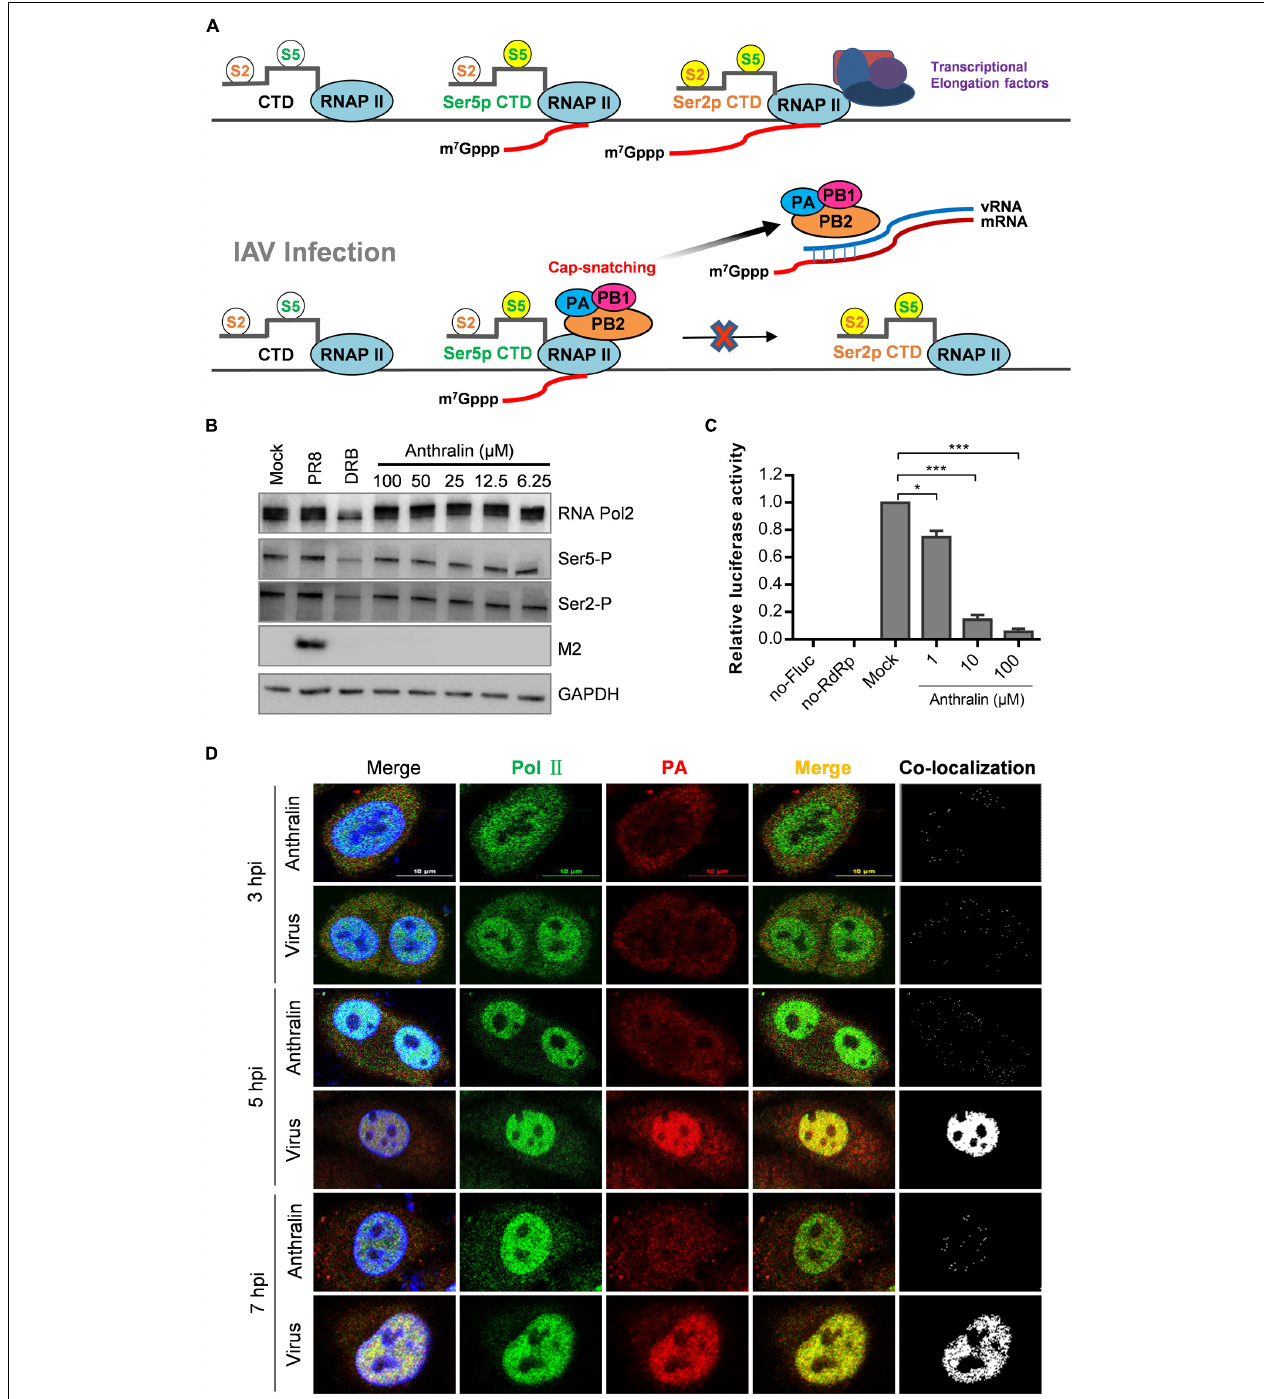
FIGURE 4 | Anthralin does not inhibit the host RNA polymerase activity. (A) The model illustrates the phosphorylation of Ser5 and Ser2 of RNAPII (phosphorylated residues are highlighted in bright yellow) and the synthesis of the initial cap structure of transcription. When the cell is infected with the IAV, the viral RdRp complexes complete RNA replication cycle by snatching the caps produced by host RNA II. (B) The expression of total RNAPII, serine 2 phosphorylated and serine 5 phosphorylated RNAPII, and the M2 protein of IAV were detected by Western blot. DRB used as a positive inhibitor of transcription initiation (lanes 3). (C) Various concentrations of anthralin were incubated with HEK293T cells stably transfected with pGL6-luc (Fluc), pcDNA3.1 expression vector for influenza virus PA, PB1, and PB2 proteins, and pRL-SV40-N (Rluc) as a transfection control, and DMSO was included as the vehicle control. (D) A549 cells infected with PR8 virus were treated with 50 µ M anthralin during the whole culture process, until being fixed at different time points and the co-localizations of RNAPII and vRdRp were observed using a confocal microscope. The first merge includes PolII, PA and DAPI, whereas the second merge does not include DAPI.